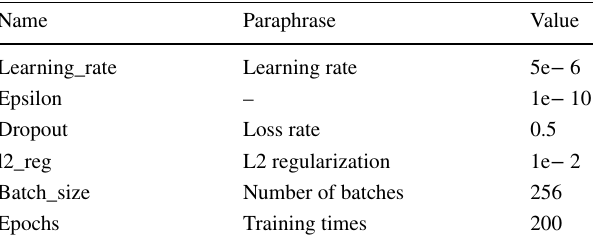
Table 4 The parameters of deepFM